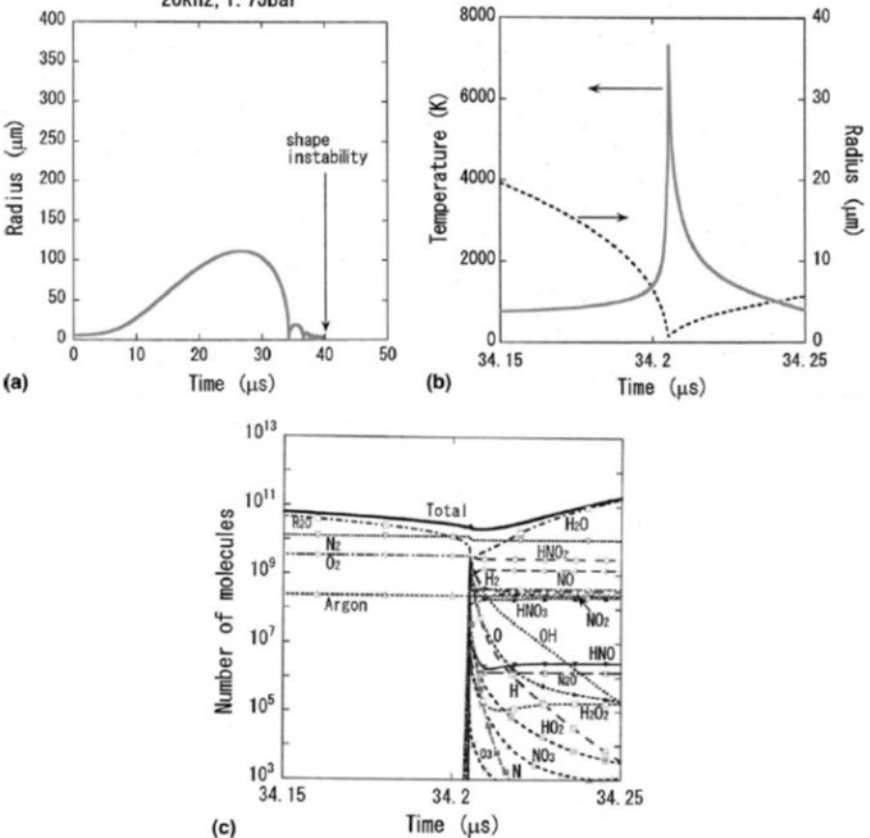
Figure 9. Calculated results when the acoustic amplitude is 1.75 bar [33]. The other conditions are the same as those in Figure 8. ( a ) The radius-time curve for one acoustic cycle. A bubble disintegrates into daughter bubbles by shape instability at t = 39.85 µ s. ( b ) The temperature inside a bubble and the bubble radius as a function of time at around the end of the bubble collapse only for 0.1 µ s. ( c ) Numbers of molecules of various species inside a bubble as a function of time with the same time axis as that of ( b ). The vertical axis is in logarithmic scale. Copyright 2005, with the permission from Elsevier. The results of numerical simulations for an argon bubble in 5 °C water irradiated by 20 kHz ultrasound are summarized in Figure 10 [34]. As already discussed, the peak bub- ble temperature is nearly constant at relatively high acoustic amplitudes (Figure 10a). As the liquid temperature is lower than that in Figure 8, the peak bubble temperature of vap- orous bubbles in Figure 10 is higher than that in Figure 8 [25]. According to the numerical simulations, the mechanism of the SL light emission from vaporous bubbles is chemiluminescence of OH as well as emissions from weakly ionized plasma formed inside a bubble (Figure 10b) [34]. The intensity of chemiluminescence of OH is estimated by the rates of the reactions O + H + M OH* + M and OH + H + OH OH* + H 2 O, where OH* is the excited OH radical and M is the third body. The excited OH radical emits light (chemiluminescence) by OH* OH + h ν . The quenching of molecular emissions by collisional deexcitation is taken into account in the calculations [34]. Inside a bubble at the end of the bubble collapse, temperature and pressure are extremely high, which results in strong quenching of molecular emissions by collisional deexcitation. Nev- ertheless, chemiluminescence of OH is still intense in vaporous bubbles. Ndiaye et al. [37] experimentally reported that the relative vibrational population distribution of OH obtained from the MBSL spectra deviates strongly from the equilib- rium Boltzmann distribution. This may be caused by the chemiluminescence origin of OH-line emissions.